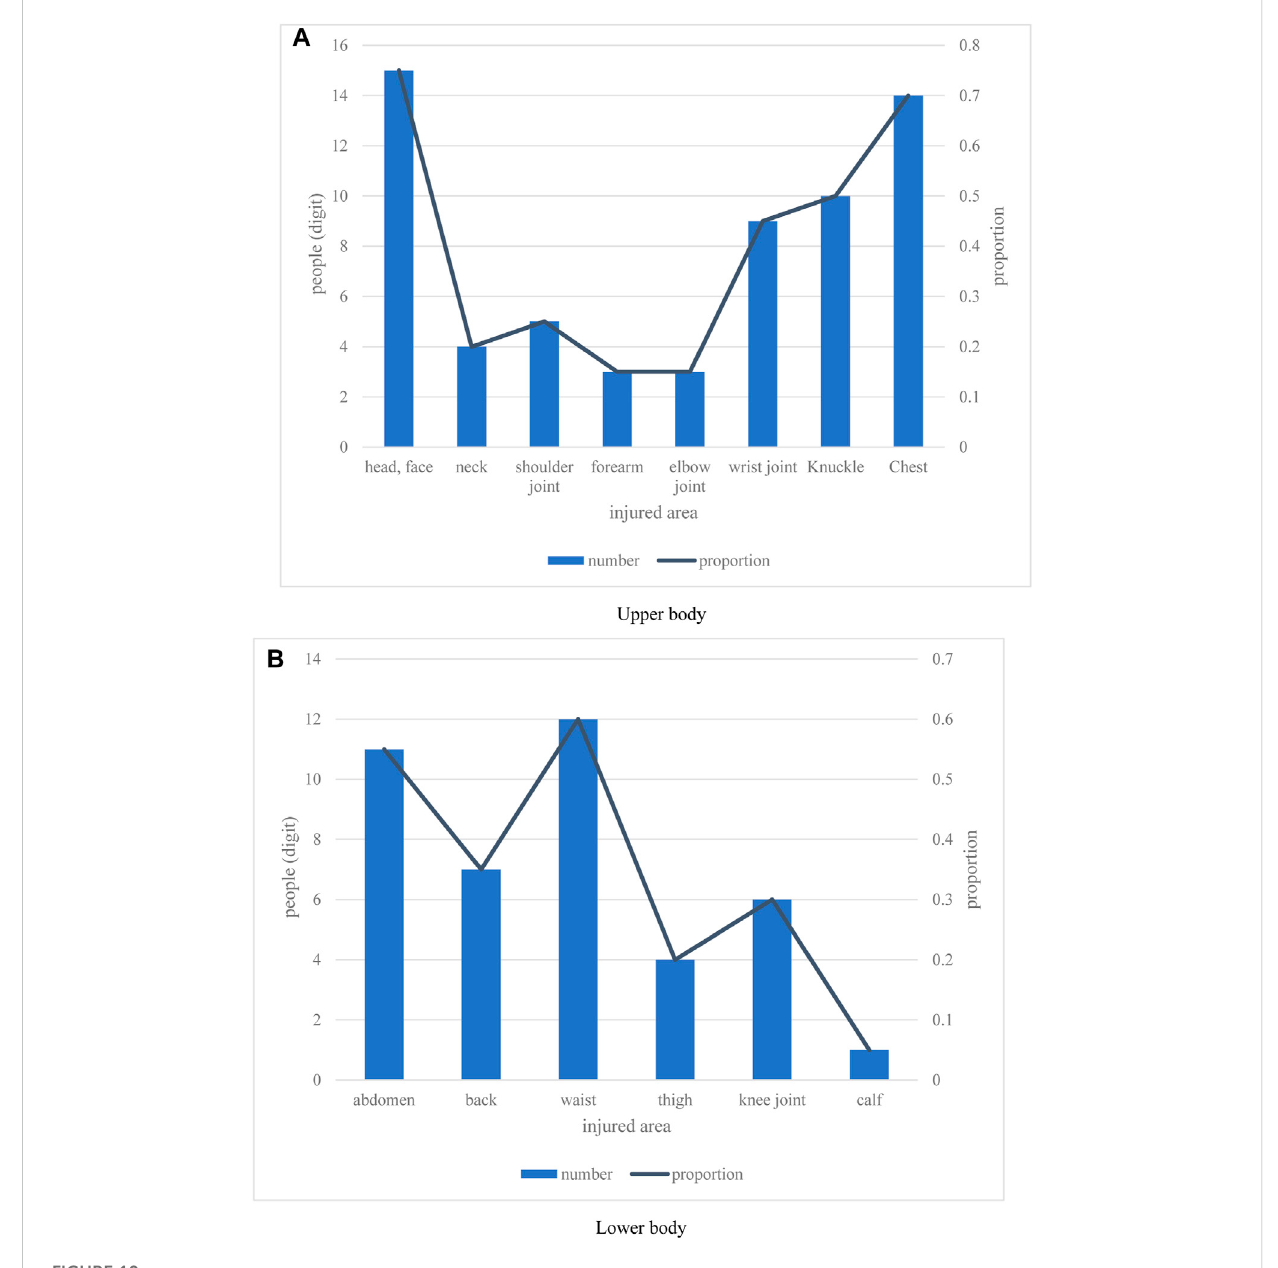
FIGURE 10 Statistics of injured parts. (A) Upper body. (B) Lower